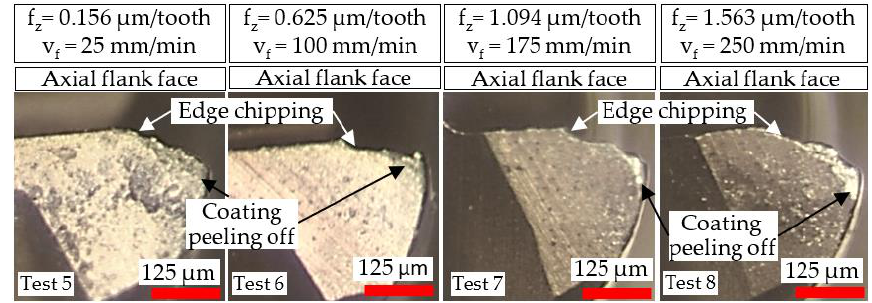
Figure 8. Tool wear micrographs for the Ø 1 mm end-mills at test cessation.